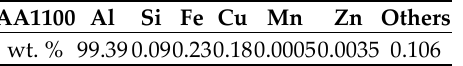
Table 1. Chemical composition of the aluminum alloy